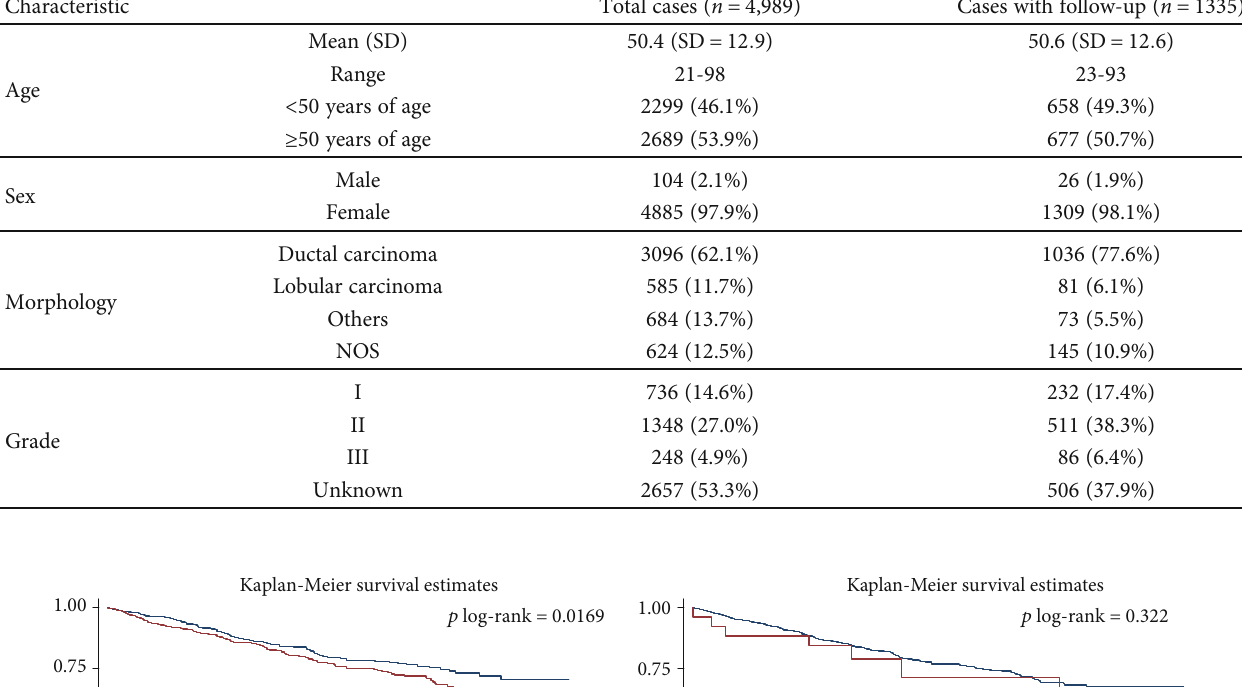
Table 1: Main characteristics of breast cancer patients (total and cases with follow-up) in Northwest of Iran, between 2007 and 2016.